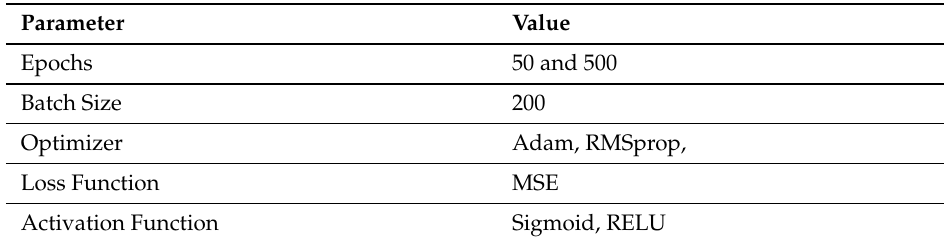
Figure 4. Vector visualization of dataset. Table 2. Hyperparameters for the LSTM network.